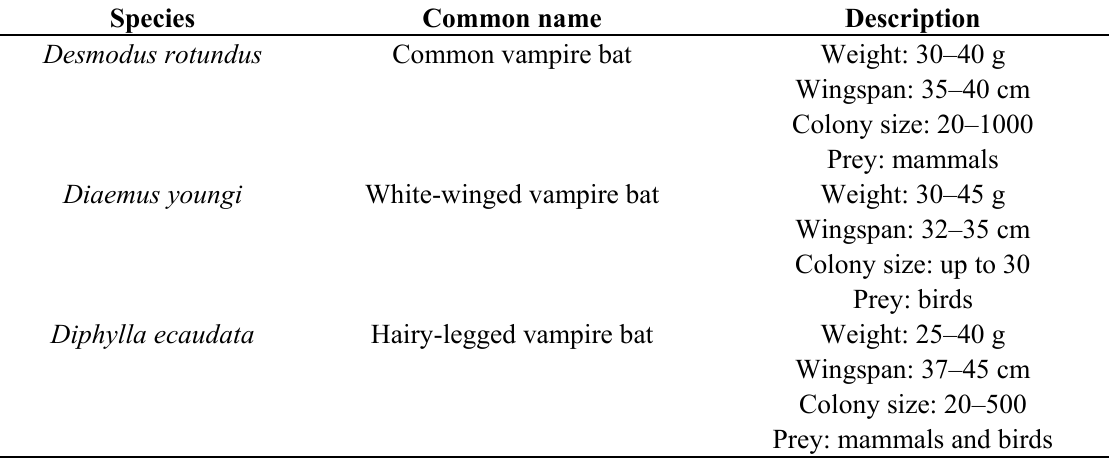
Table 1. The blood feeding bats of Latin America. All belong to the family Phyllostomidae or New-World leaf-nosed